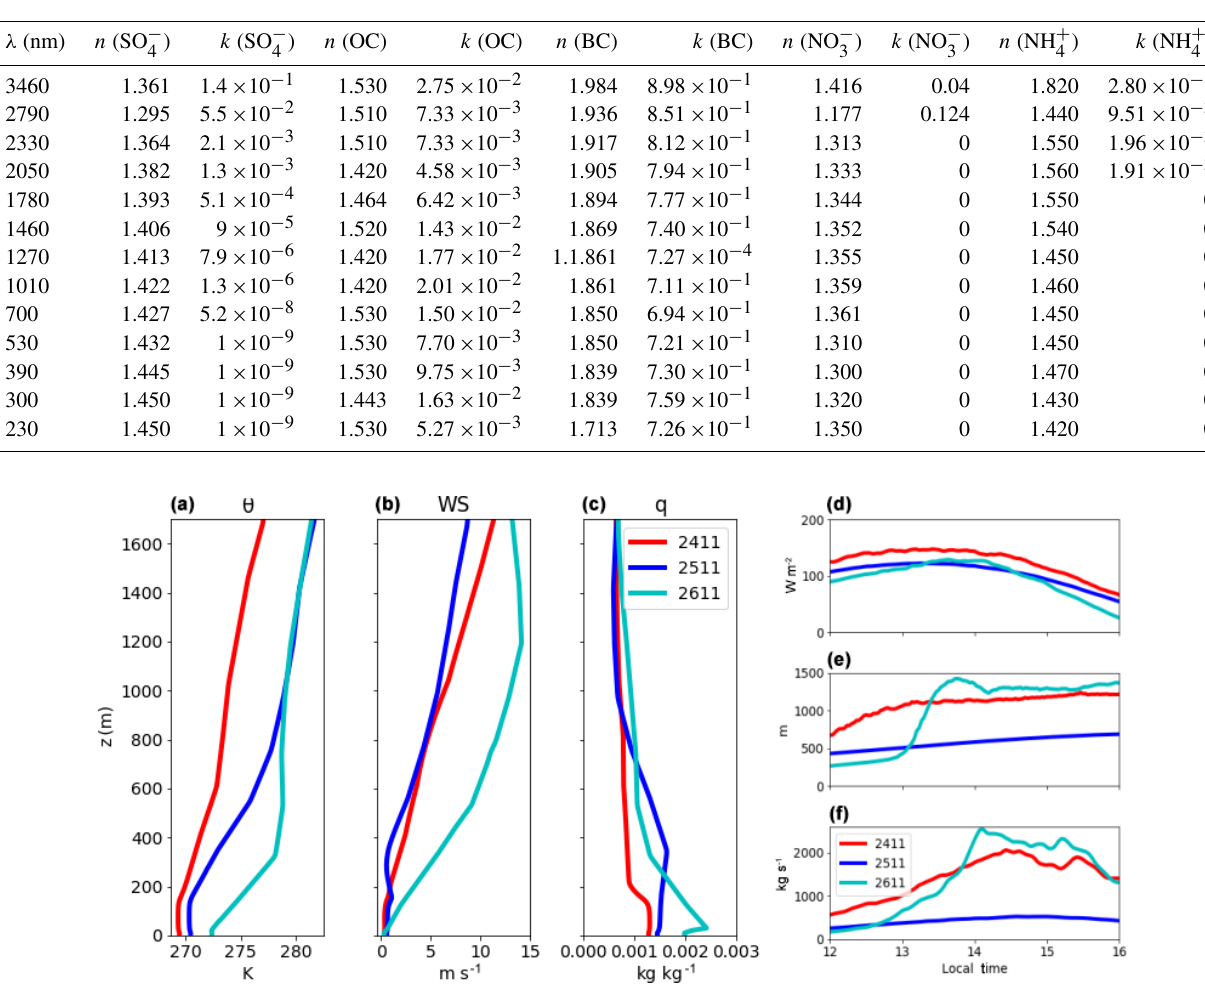
Figure 4. (a–c) Initial vertical profiles of potential temperature ( θ ), wind speed (WS) and total water mixing ratio ( q ), and (d) sensible heat flux, (e) height of maximum gradient in θ and (f) vertical integral of TKE for 24 November (red), 25 November (blue) and 26 November (turquoise) for simulations with no aerosols (case 1).